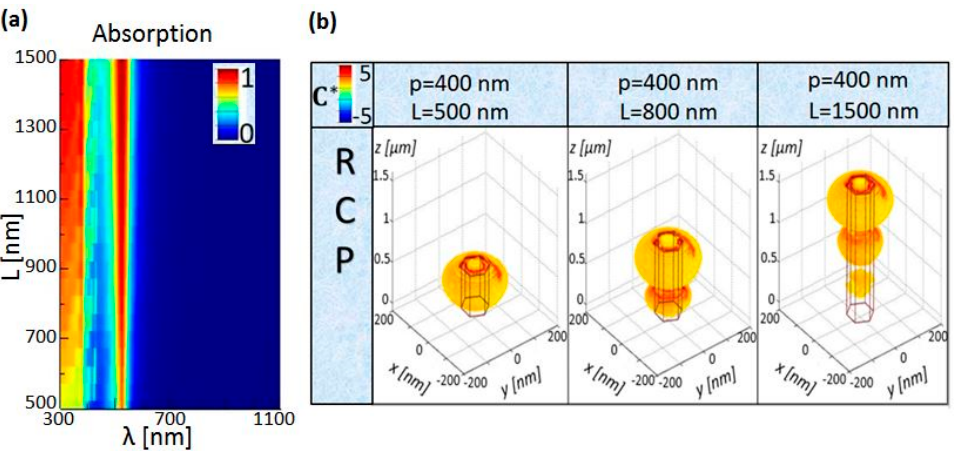
Figure 4. ( a ) Absorption dependence on the NW length for r = 50 nm and p = 400 nm. ( b ) C* distribution in the unit cell for L = 500 nm, L = 800 nm, and L = 1500 nm at the resonant wavelength of 525 nm. Only RCP excitation is shown as LCP leads to the sign inversion.